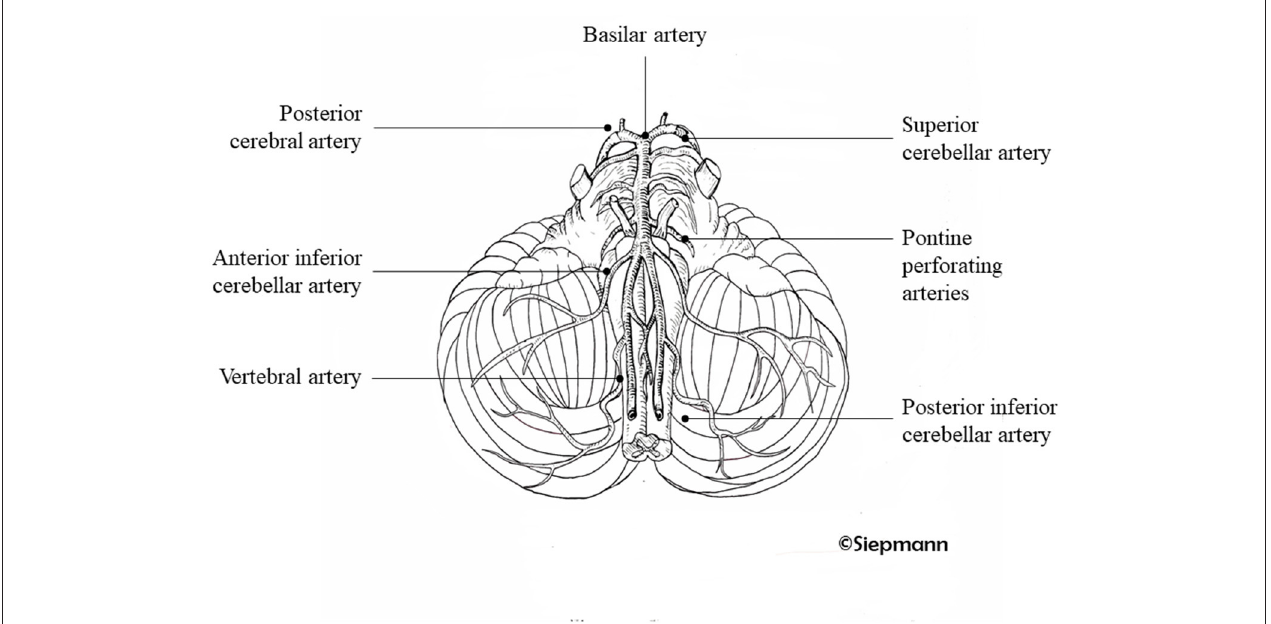
FIGURE 1 | Posterior arterial circulation system. Illustration of the branches of the vertebral arteries supplying the cerebral posterior circulation system. Drawing kindly provided by Antje